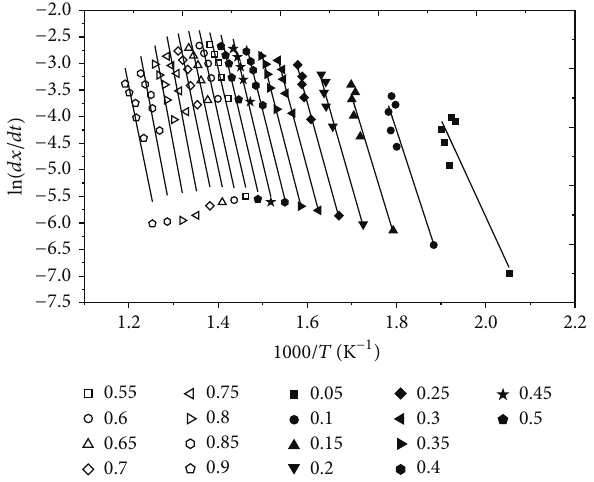
Figure 7: Friedman plots of lignite coal pyrolysis at different values of conversion.